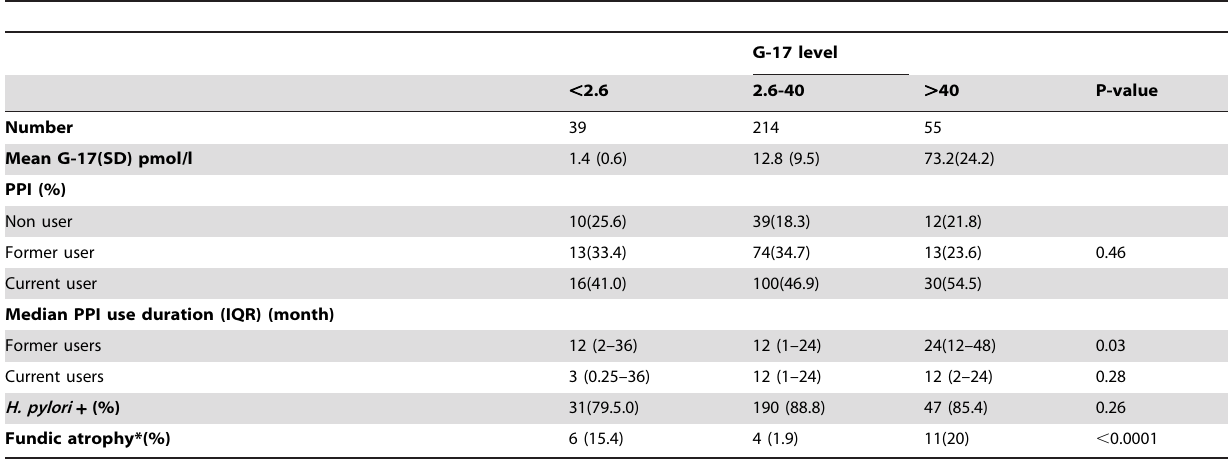
Table 3. Proportion of PPI use, H. pylori infection and fundic atrophy among categories generated by G-17 cutoff